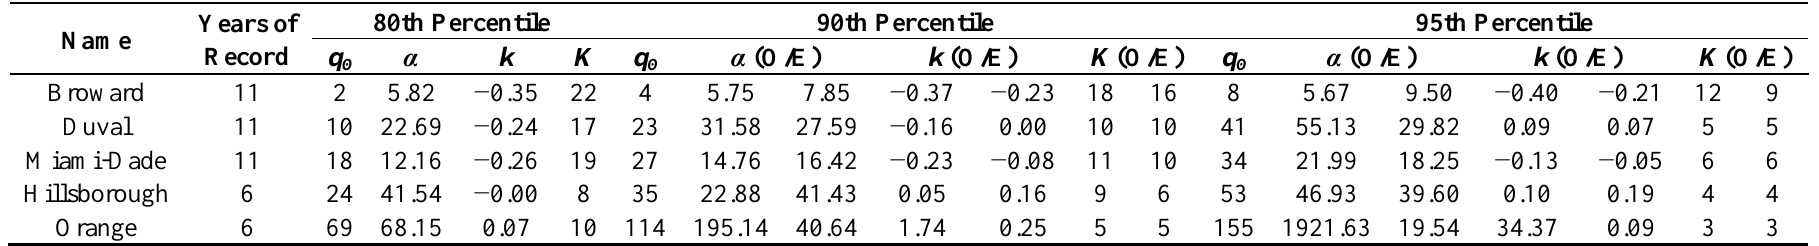
Table 3. Observed and expected parameters of magnitudes upon raising the thresholds to the 90th and 95th percentile levels (Definition 2). Note: q , the threshold; α , the scale parameter of GPD; k , the shape parameter of GPD; K , the total number of peak events in all flu 0